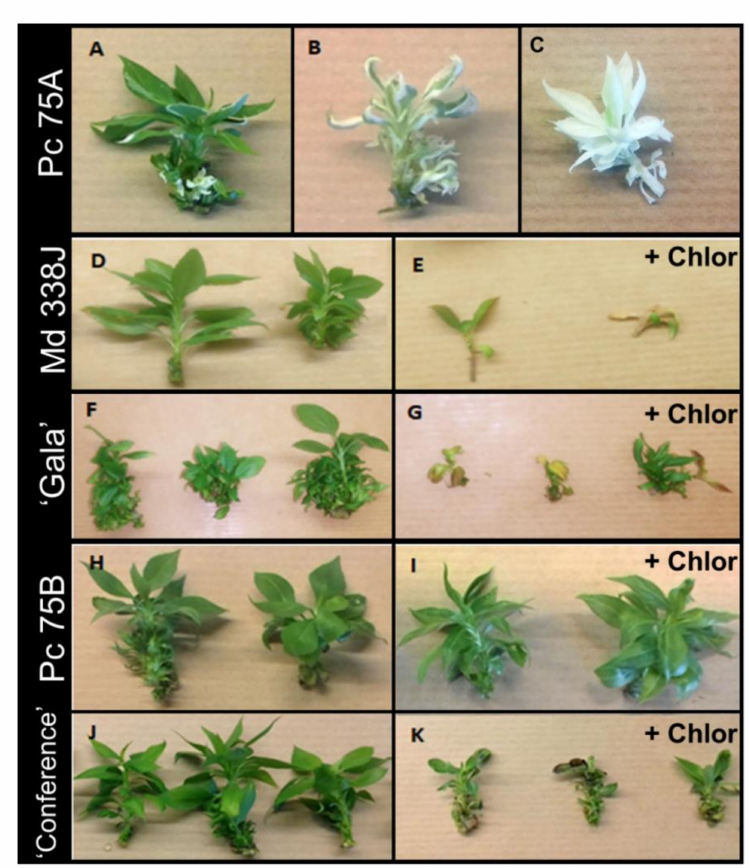
Figure 4. Transgenic lines phenotype for base-editing of PDS and ALS genes. PDS-related phenotypes for P. communis line 75A phenotype ( A – C ); ALS-related phenotype for M. domestica for line 338J ( D , E ) and ‘Gala’ ( F , G ) as control (+Chlor = 2 months on chlorsulfuron at 1 µ g/L). ALS-related phenotype for P. communis line 75B ( H , I ) and ‘Conference’ as control ( J , K ) (+Chlor = 2 months on chlorsulfuron at 2 µ g/L). P. communis (Pc); M. domestica (Md); Chlorsulfuron treatment